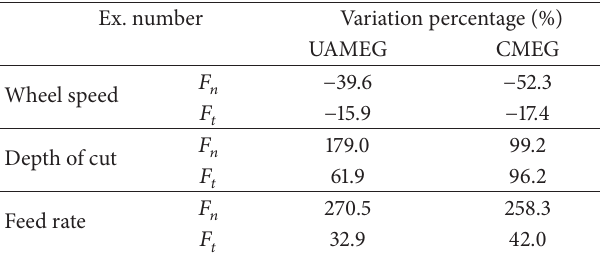
Table 4: Variation percentages of the grinding forces with/without ultrasonic